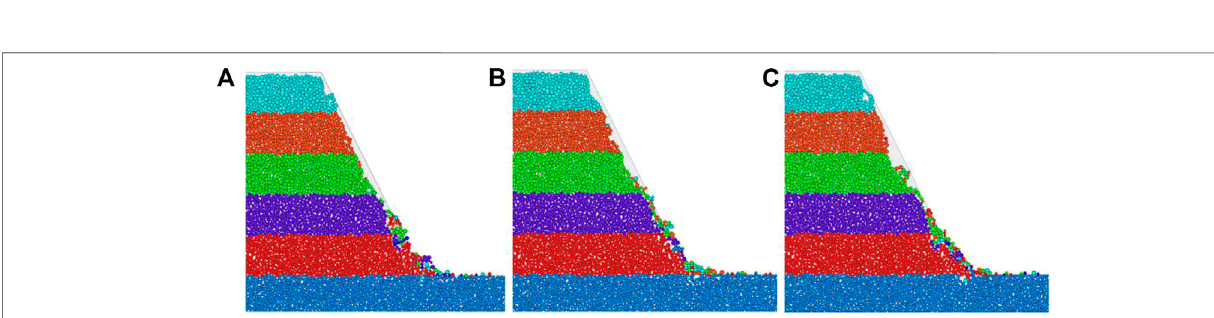
FIGURE 9 | Trajectories of different monitoring points. (A) , (B) , and (C) are for 5,247, 649, and 5,529 measuring spheres, respectively.